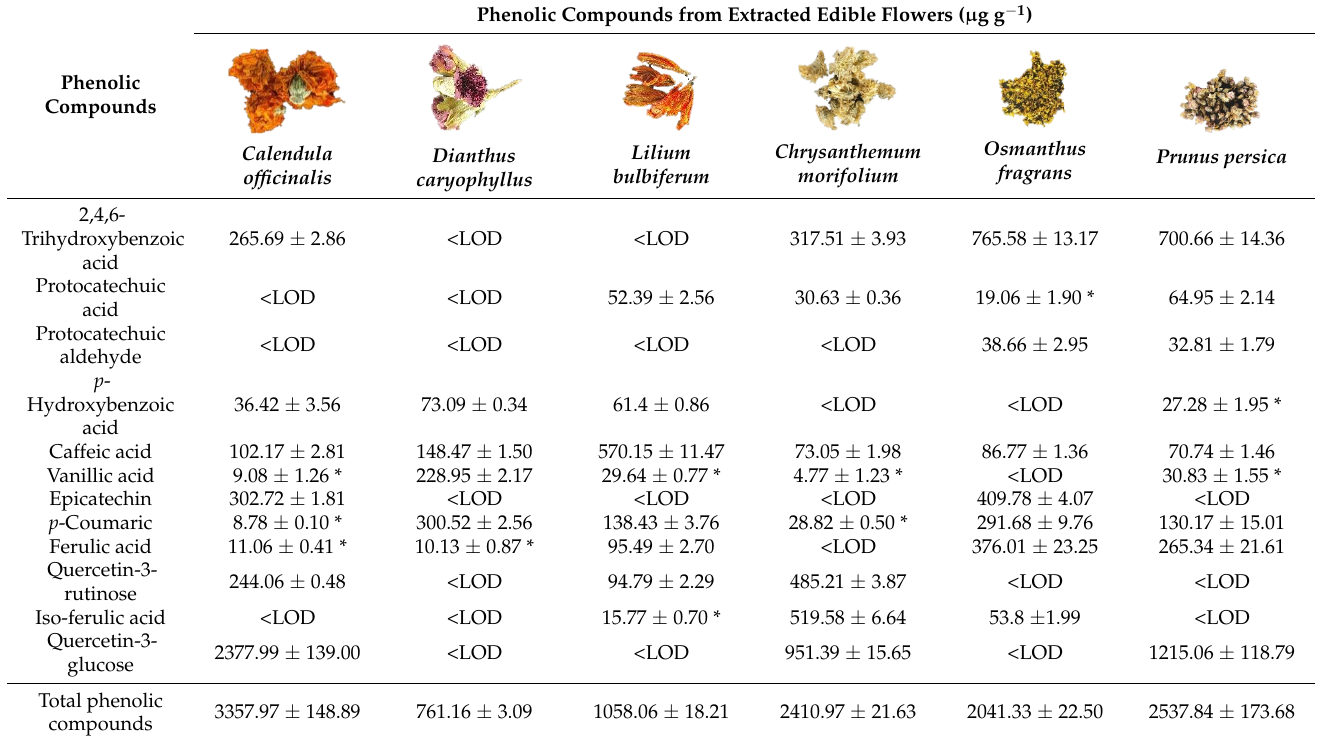
Table 4a. Individual phenolic compounds from different dried edible flowers.